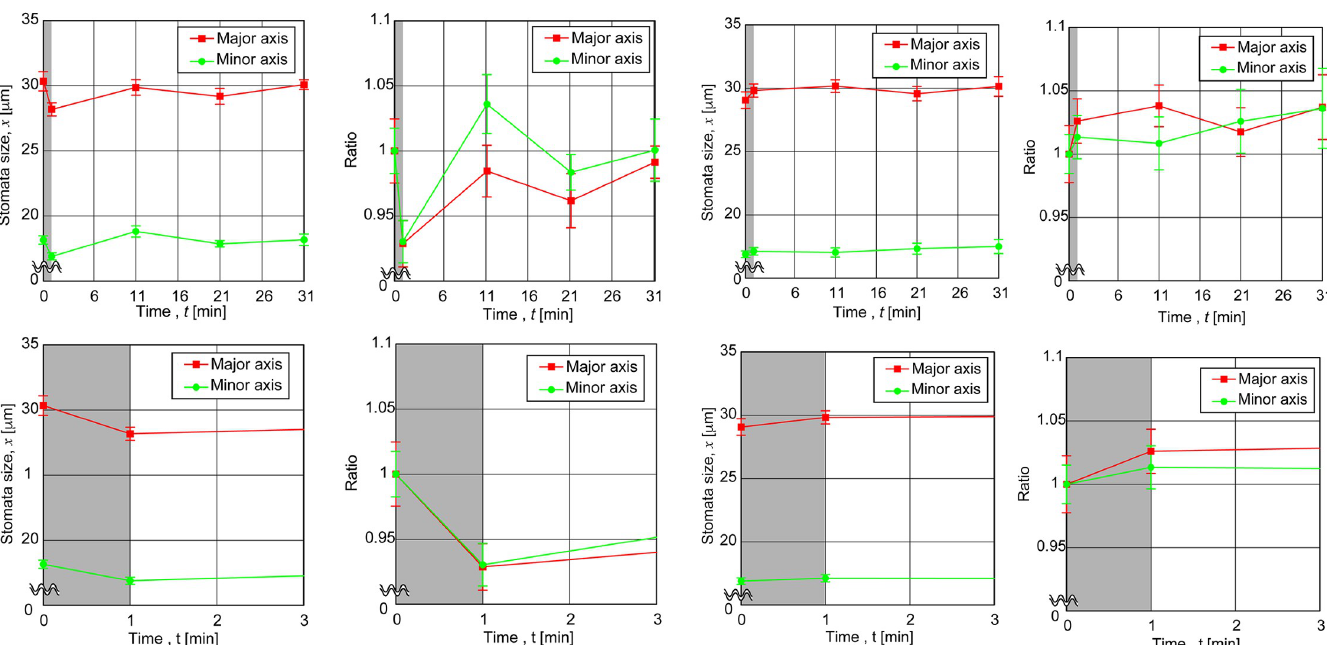
Fig 10. The stomatal sizes, major and minor axes lengths represented respectively in red square and circle as a function of time shown on the top left and the ratio of stomatal lengths on the top right for 10kHz sound (A) and for control (B). The gray shaded regions shown at the top for the stomatal lengths and ratio are magnified to show respectively the first three seconds in the bottom row. Here the ratio is taken with the stomatal sizes measured after exposure to those before exposure.